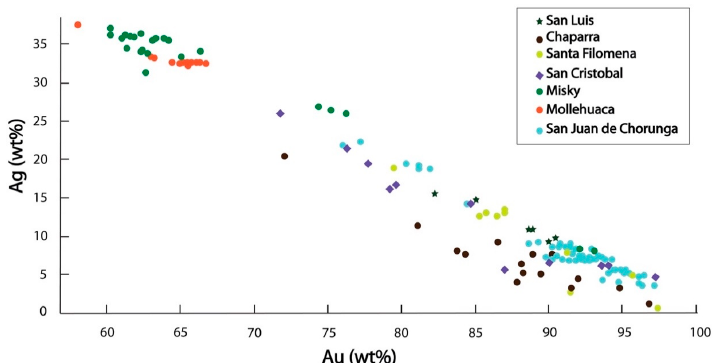
Figure 8. Gold and silver concentrations scatterplot for gold and electrum (EMPA data) from deposits in the Arequipa region. Data are plotted in weight per cent (wt%). Mollehuaca and San Juan de Chorunga data set in this study. Misky, Santa Filomena, San Cristóbal, Cháparra, and San Luis data set are from Alfonso et al., 2019.